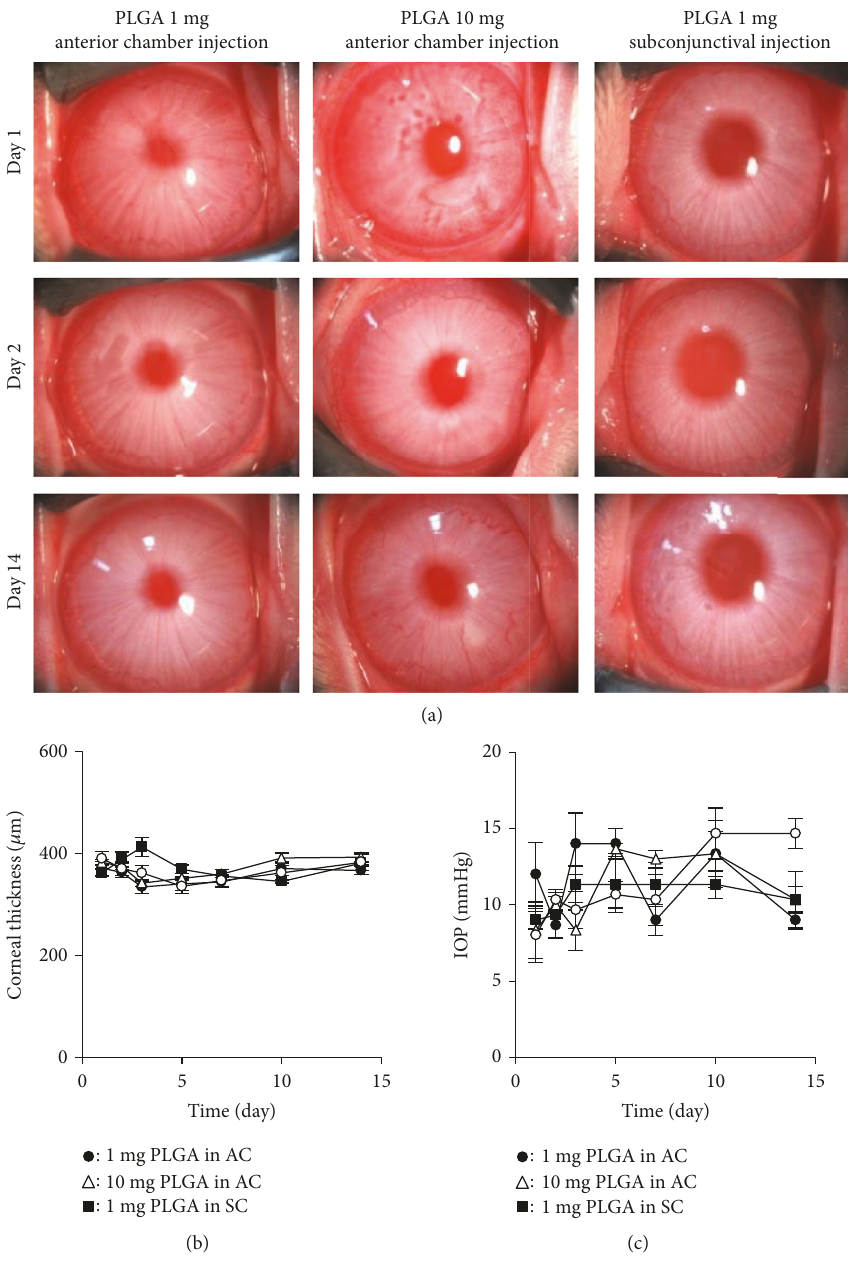
Figure 3: Safety assessment of poly lactic/glycolic acid (PLGA) microspheres in a rabbit eye. (a) One or 10mg PLGA microspheres suspended in 200 μ L phosphate bu ff er solution (PBS) was injected into the anterior chamber, and 1 mg PLGA microspheres suspended in 200 μ L PBS was injected into the subconjunctiva. Nine right eyes of 9 rabbits were used for the experiments ( n = 3 ). Anterior segments were evaluated by slitlamp microscopy for 14 days. (b, c) Corneal thickness and intraocular pressure were evaluated for 14 days and are shown in the graph. The central corneal thickness was evaluated by ultrasound pachymetry. Intraocular pressure was determined with a